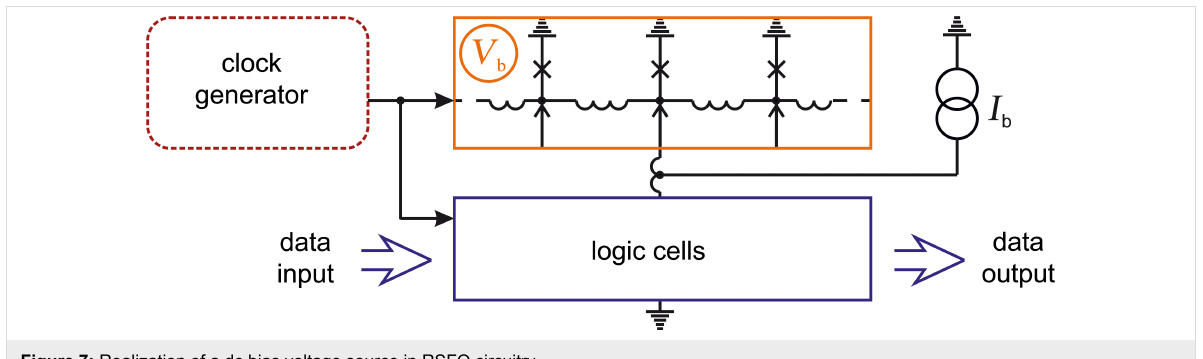
Figure 7: Realization of a dc bias voltage source in RSFQ circuitry.